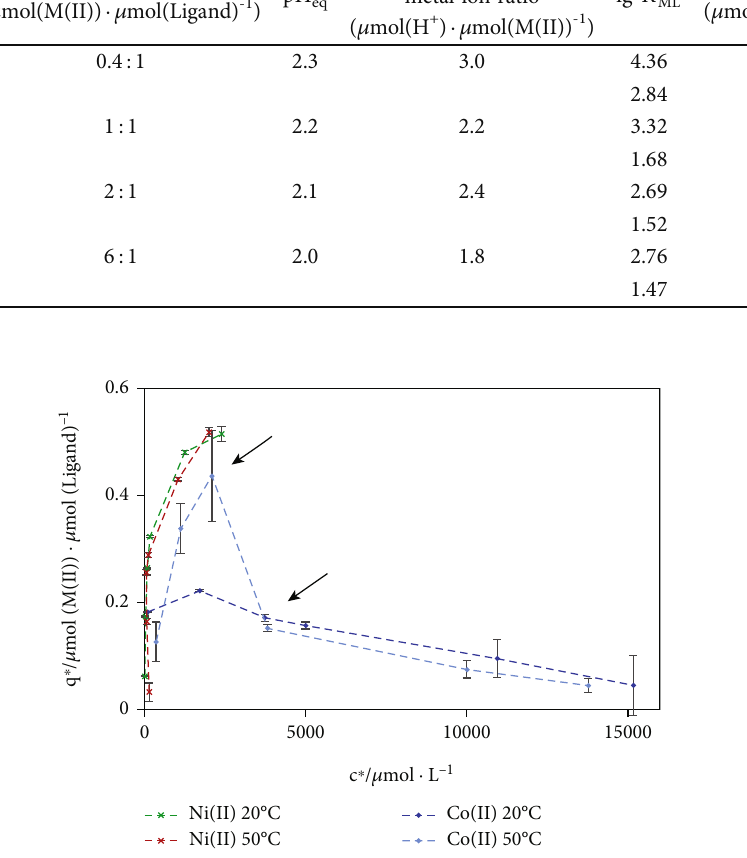
Figure 3: Adsorption isotherms of HSU331 for the dual-component systems with a molar ratio of Ni(II) :Co(II) 1:3 at T = 20 ° C and 50 ° C. Arrow marked data points denote the limit values from which the metal ion :ligand ratios are ≥ 1. Each isotherm consists of six data